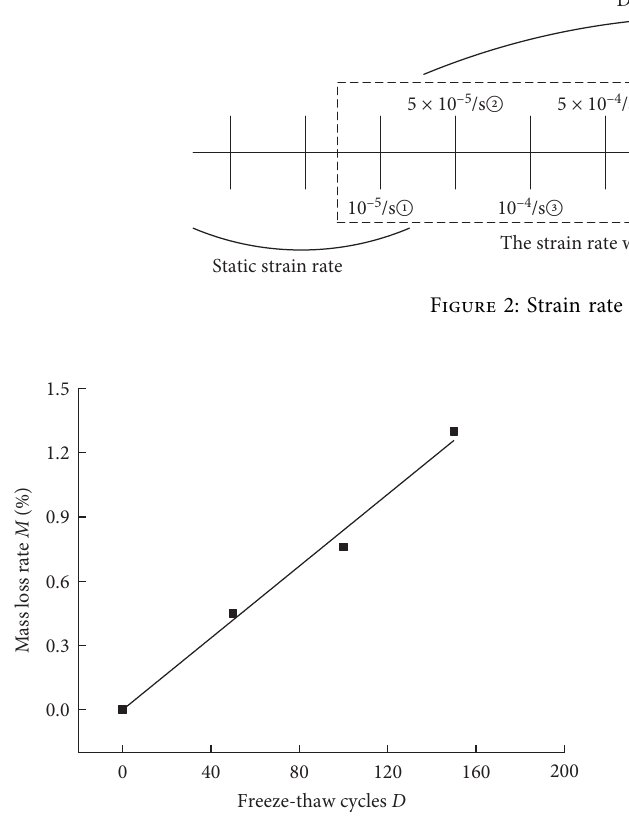
Figure 3: Number of freeze-thaw cycles and mass loss